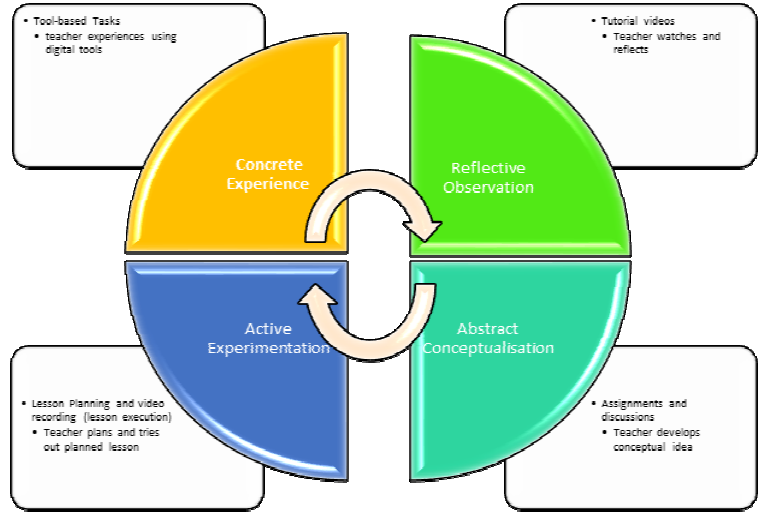
Figure 2: Adapted Kolb’s Experiential Learning Cycle (1984) for Online Training